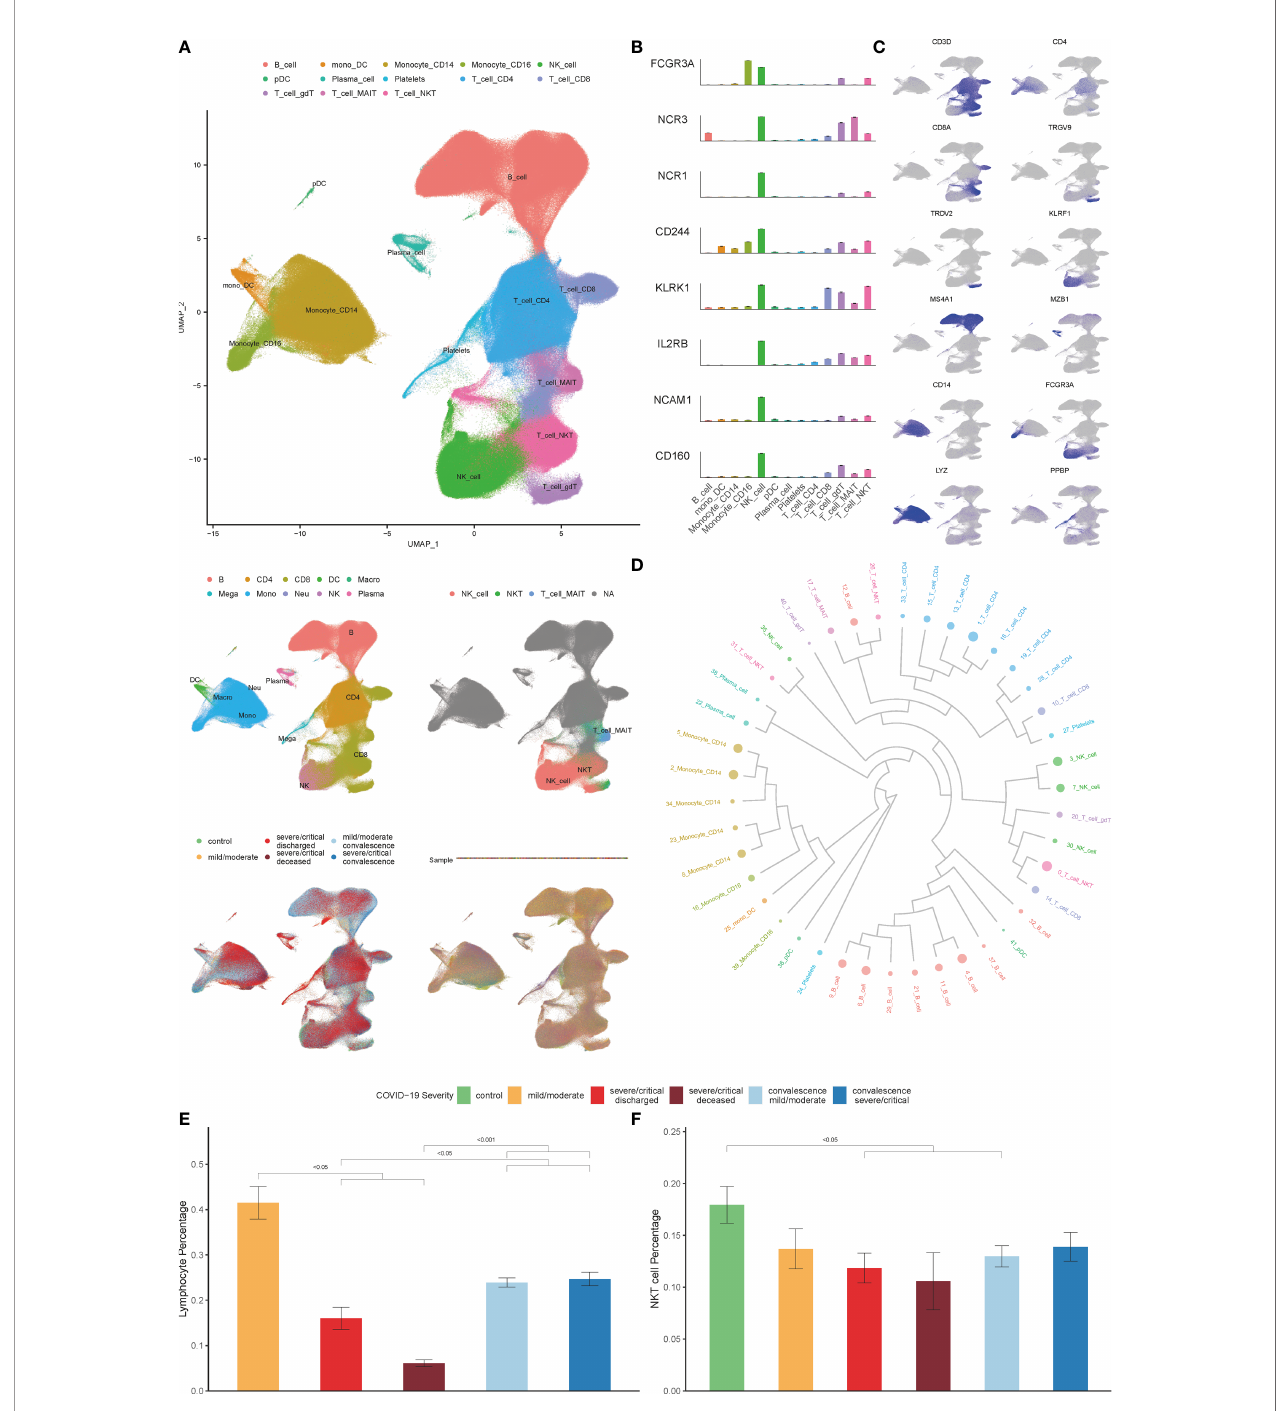
FIGURE 1 | Single-cell transcriptional pro fi ling of PBMCs in COVID-19. (A) Integration analysis results of patients with COVID-19 and controls showing UMAP visualization, including integration analysis result of 13 major cell clusters annotated (top), the cell clustering results in origin data (middle left), the result of NKT cell clusters annotated by SingleR (middle right), the result of patients with COVID-19 and healthy controls (bottom left), the result of PBMCs samples with no batch effect observed (bottom right). (B) Expression of NK-associated genes, including CD16 ( FCGR3A ), NKP30 ( NCR3 ), NKP46 ( NCR1 ), 2B4 ( CD244 ), NKG2D ( KLRK1 ), CD122 ( IL2RB ), CD56 ( NCAM1 ) and CD160 in cell clusters. (C) Known cell markers used to identify PBMCs cell types. (D) The result of cell clusters showing by dendrogram (E) Percentage of lymphocytes in COVID-19 patients derived by the routine blood test. (F) Percentage of NKT cells in COVID-19 patients and controls derived by single cell datasets. (Wilcoxon